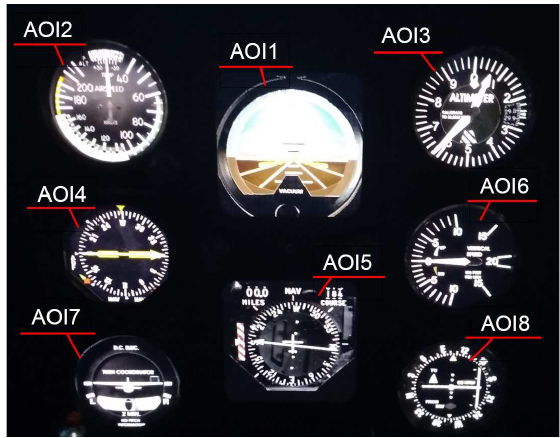
Figure 4. The view of the cockpit instruments used in the aircraft model employed in the